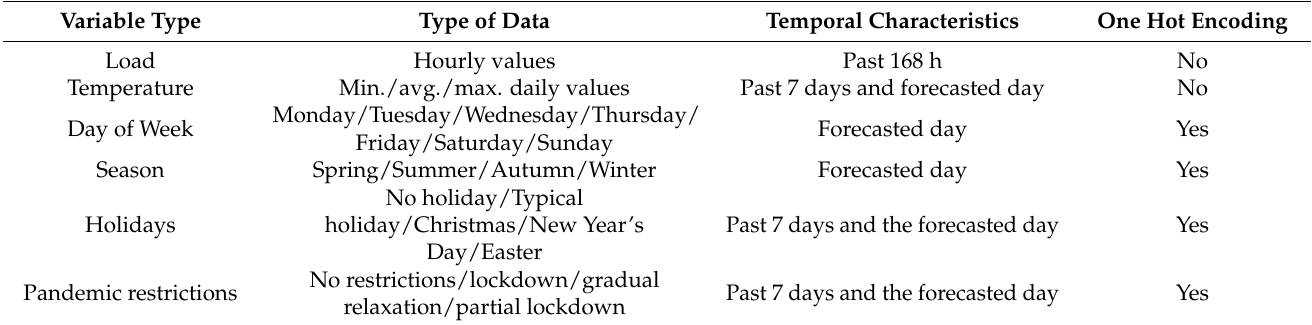
Table 2. Input variables of the proposed